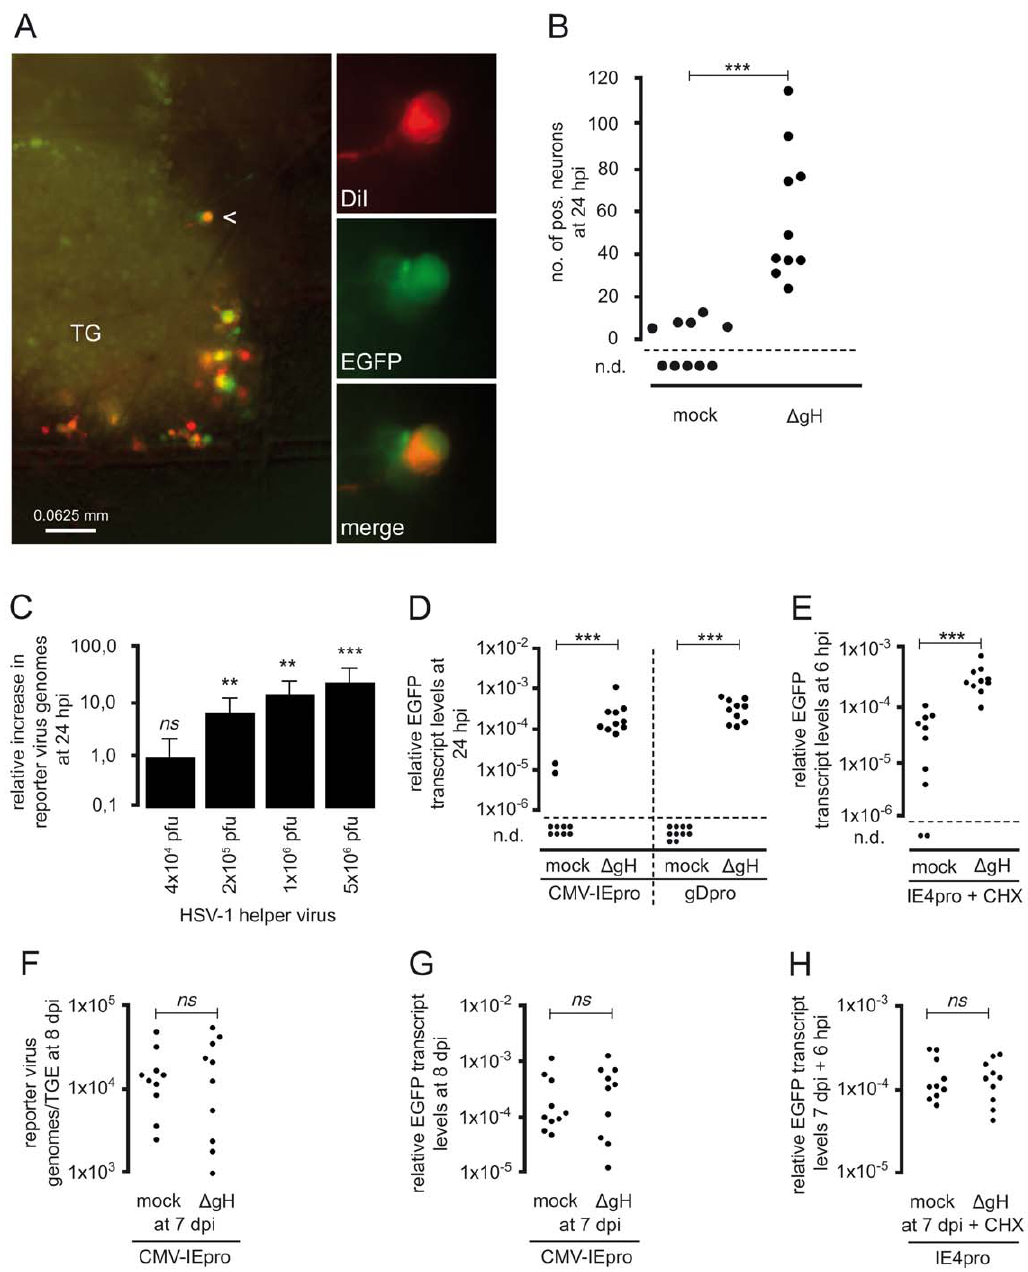
Figure 5. Transactivation of HSV-1 in axonally-infected TGEs by infection of the GC with HSV-1 helper virus. (A) Effect of helper virus on EGFP expression in TGEs infected in the AC with HSV-1 17 CMV-IEproEGFP. TGEs were co-infected with 1 6 10 6 pfu of the gH-negative, spread- deficient mutant HSV-1 KOS gH87 in the GC and 5 6 10 6 pfu of HSV-1 17 CMV-IEproEGFP in the AC. At 1 hpi, cultures were stained with DiI in the AC. The arrowhead indicates a typical DiI and EGFP double-positive neuron depicted at higher magnification in the right-hand images. (B) Effect of helper virus on EGFP expression in axonally-infected neurons. The numbers of positive neurons/culture infected in the AC with 5 6 10 6 pfu of HSV-1 17 CMVpro-IE EGFP and co-infected in the GC with 5 6 10 6 pfu of HSV-1 KOS gH87 ( D gH) or mock-infected are given. Differences were highly significant ( P =0.0003, unpaired t test with Welch correction). (C) Effect of helper virus on genome replication of HSV-1 after infection of the AC. Groups of ten cultures were infected in the AC with 5 6 10 6 pfu of HSV-1 17 CMV-IEproEGFP. The GC was co-infected with varying amounts of HSV-1 KOS gH87, as indicated. TGEs were harvested at 24 hpi with the helper virus, reporter virus genome levels were quantified by qPCR, and the increase of reporter virus genome levels relative to controls was calculated. The significances of helper-virus-induced increases in the median genome level of reporter virus genomes are indicated (5 6 10 6 pfu helper virus, P , 0.0001; 1 6 10 6 pfu helper virus, P =0.0021; 2 6 10 5 pfu helper virus, P =0.0015; 4 6 10 4 pfu helper virus, P =0.4359; Mann-Whitney test). Data are mean and SD values. (D) Reporter gene expression 24 h after co-infection of the GC with HSV-1 helper virus. Cultures were infected with 5 6 10 6 pfu of HSV-1 17 CMV-IEproEGFP, and HSV-1 17 gDproEGFP in the AC. Groups of ten cultures were co- infected with 5 6 10 6 pfu of HSV-1 KOS gH87 in the GC; cultures not infected with helper virus served as controls. The significances of differences in the relative transcript levels are indicated (HSV-1 CMV-IEpro EGFP, P , 0.0001; HSV-1 gDproEGFP, P , 0.0001; unpaired t test with Welch correction). (E) Helper-virus-induced transcriptional transactivation of IE gene expression in the absence of de novo protein synthesis. Cultures were infected in the AC with 5 6 10 6 pfu of HSV-1 17 IE4proEGFP in the presence of 50 m g/ml CHX. Groups of ten cultures were co-infected in the GC with 5 6 10 6 pfu of